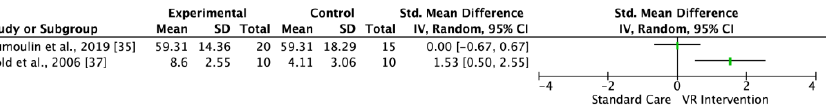
Figure 7. Comparison of VR treatment and standard care, satisfaction. SD: standard deviation; 95% CI: 95% confidence interval. Without pooling due to heterogeneity (I 2 = 83%).